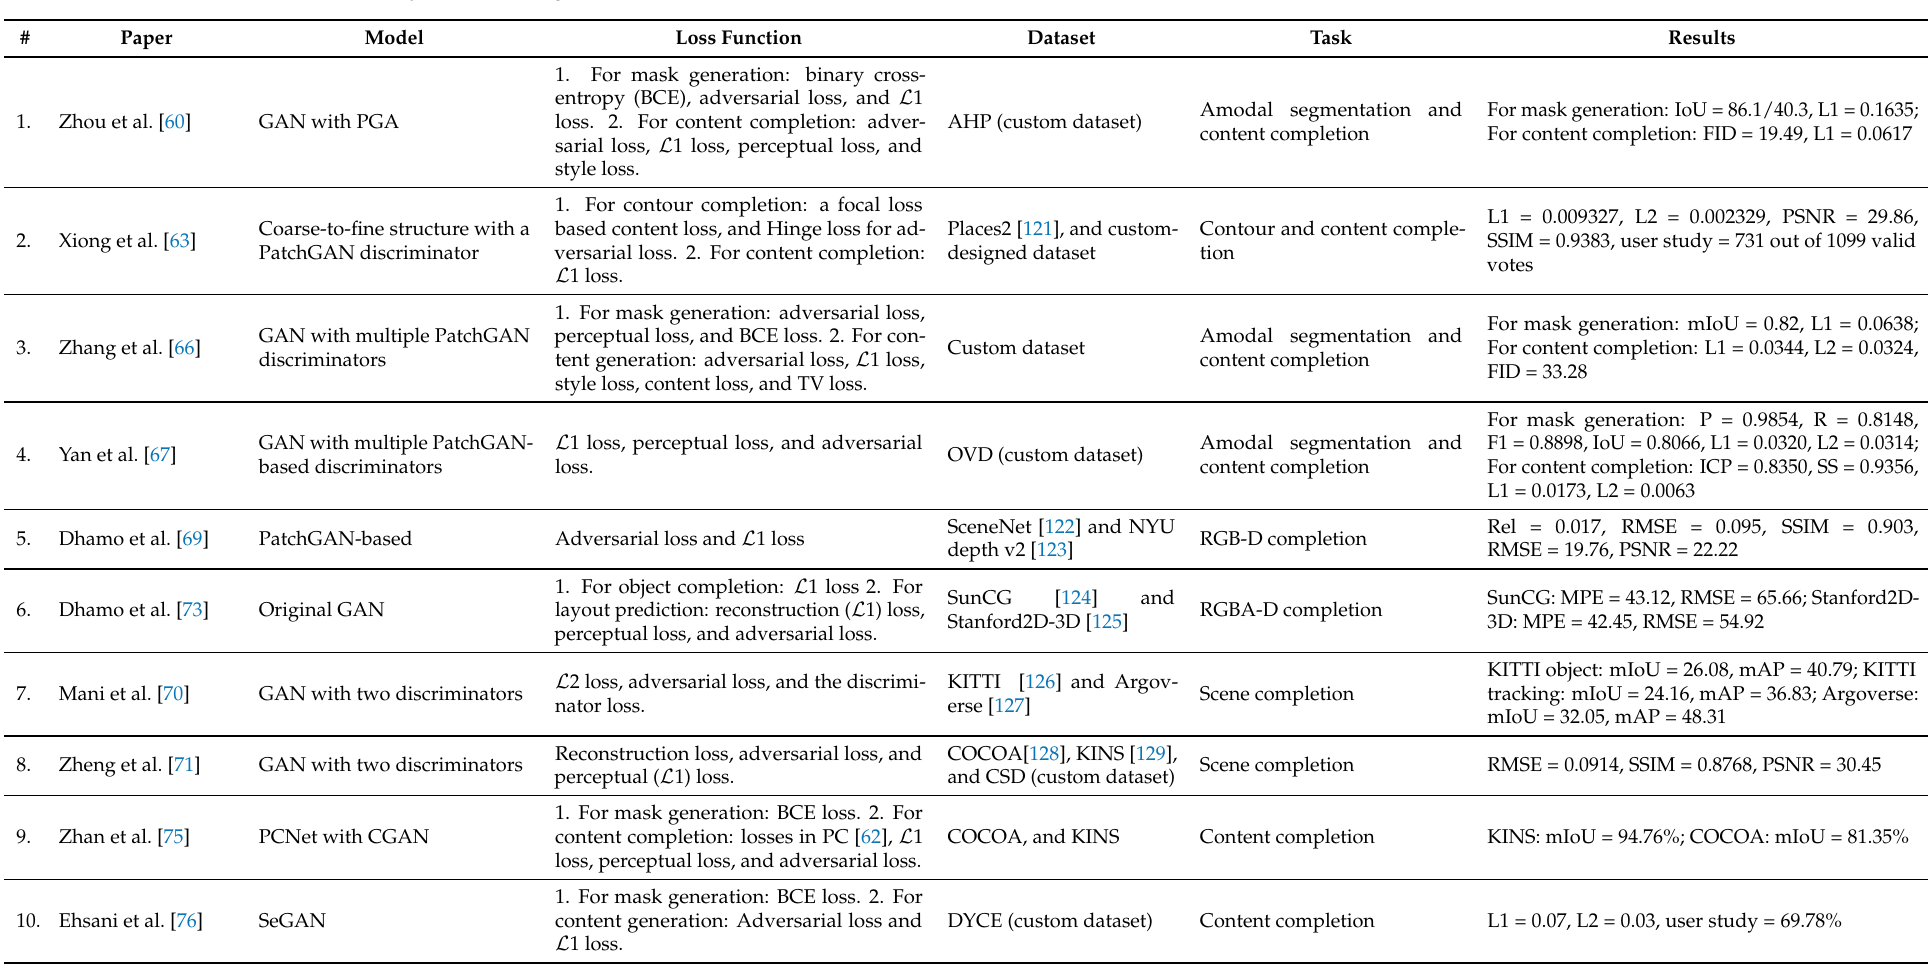
Table 4. Summary of the discussed works, highlighting the type of GAN, loss function, and the datasets that were used. The last two columns show the task that GAN was utilized for and its corresponding reported results. IoU: Intersection over Union ↑ , R: Recall ↑ , P: Precision ↑ , ICP: Inception Conditional Probability ↑